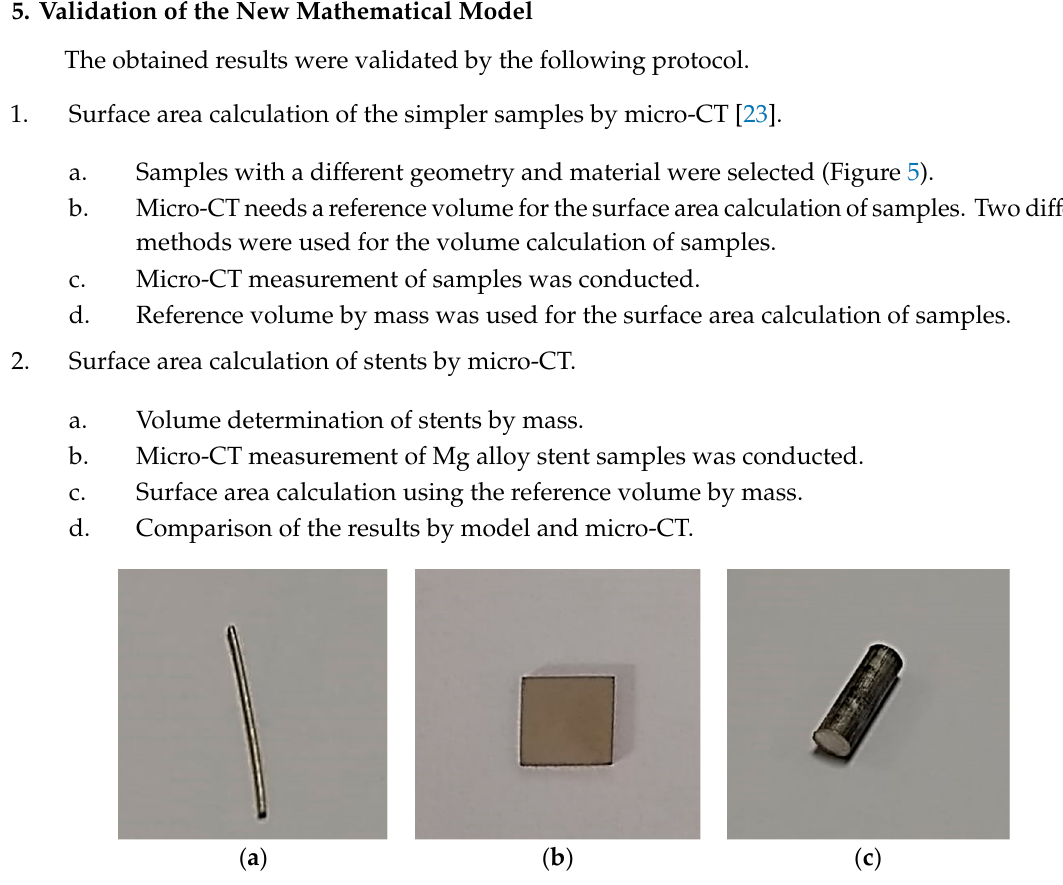
Figure 5. Samples with simpler geometry: ( a ) Mg alloy wire, ( b ) stainless steel, and ( c ) Mg alloy AZ31. Micro-CT Measurement